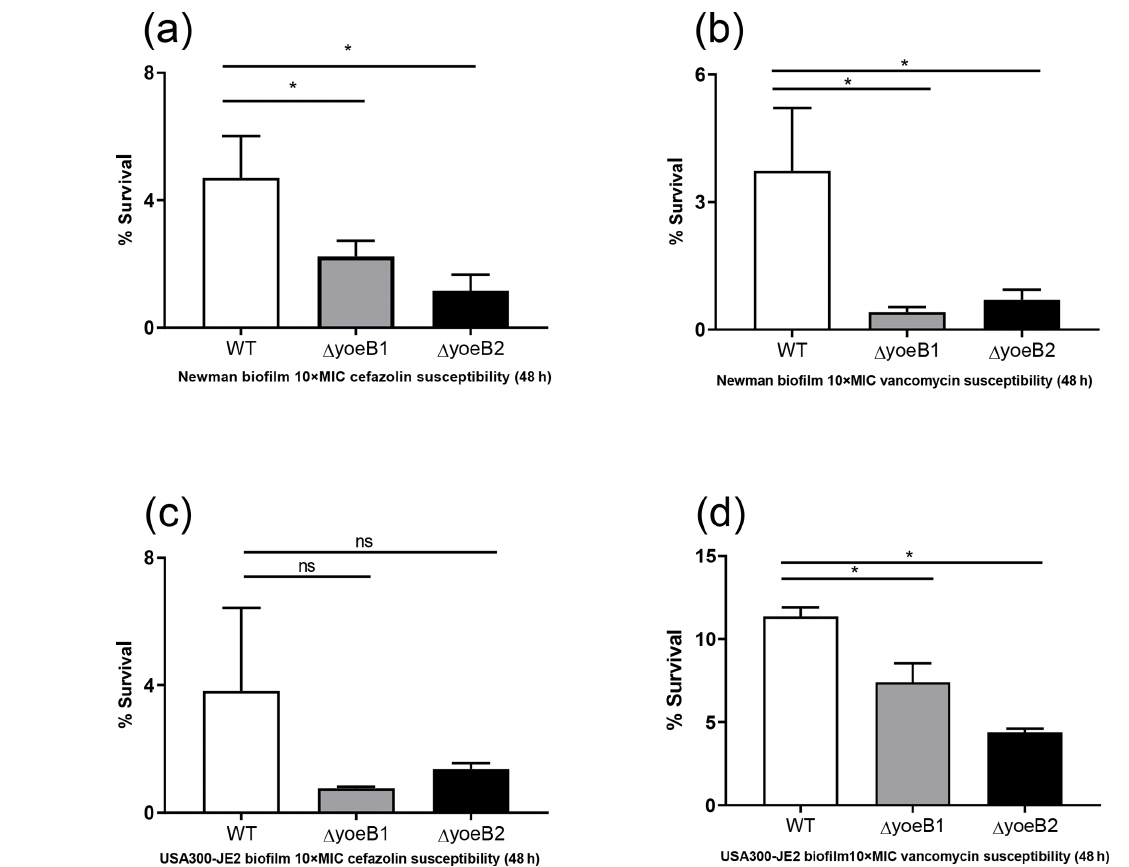
Figure 5. Loss of yoeB1 and yoeB2 increases biofilm antibiotic susceptibility. Deletion of yoeB results in a decrease in biofilm survival in the Newman strain background after treatment with both (a) 10X MIC cefazolin and (b) 10X MIC vancomycin. No reduction in biofilm survival was observed when JE2 WT and yoeB mutants were treated with (c) cefazolin, but differences in biofilm survival were observed between WT and yoeB mutants when biofilms were treated with (d) vancomycin (ns: not significant, * p < 0 . 05).